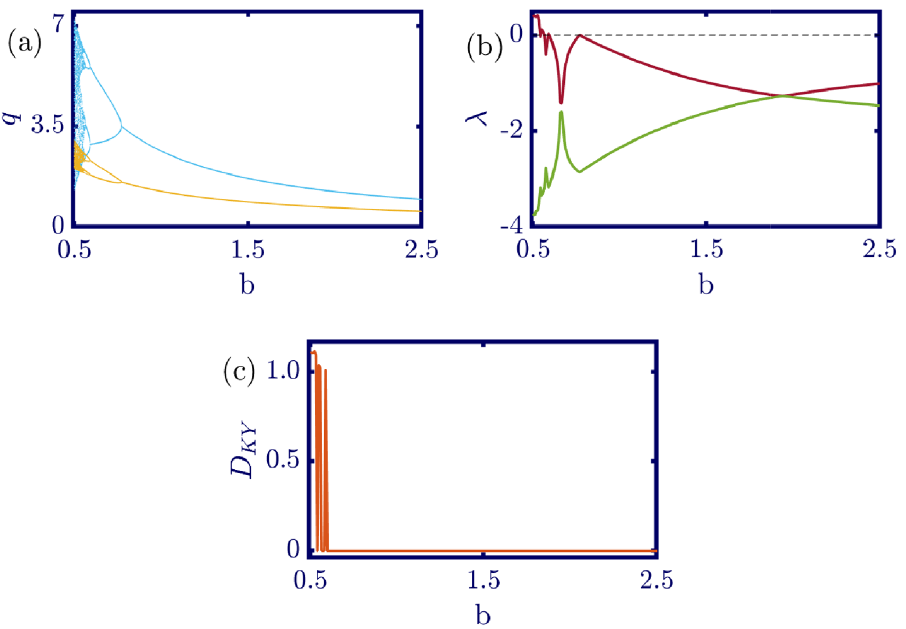
Fig 4. Eq (13) dynamics concerning parameter b with a = 6, c 1 = 2, c 2 = 1, d 1 = 0.5, d 2 = 1, v 1 = 0.1, v 2 = 1 and initial conditions q 1 (0) = q 2 (0) = 1. (a) Bifurcation diagram, (b) Lyapunov exponents spectra, and (c) Kaplan-Yorke dimension. The chaotic behavior is only observable for a small range of the parameter. Thus, the stability of the market can be easily achieved by selecting parameter b in a wide range of values that results in the Nash equilibrium. In the sub-figure (a), the cyan points represent the data for the leader firm ( q 1 ), whereas, the yellow points represent those for the follower firm ( q 2 ), and in sub-figure (b), the red and green points present the Lyapunov exponent spectra for the leader and follower firms respectively, namely λ 1 and λ 2 .